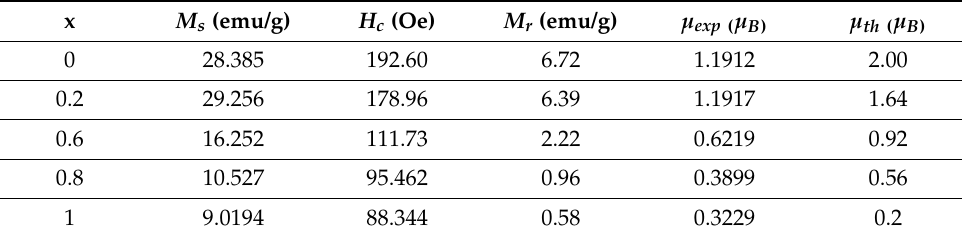
Table 6. The magnitudes of saturation magnetization ( M s ), coercivity ( H c ), remnant magnetization ( M r ), and experimental and theoretical magnetic moments ( µ exp , µ th ) of Ni + 2 0.2, 0.6, 0.8, and